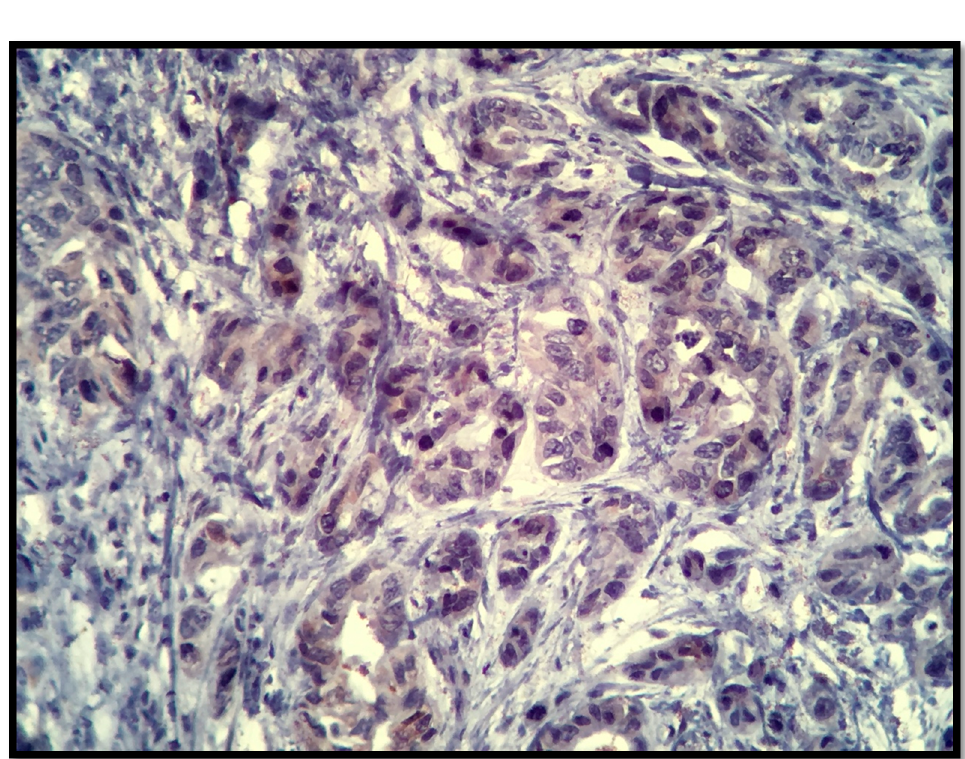
Figure 4. PR, 40×, 1%.